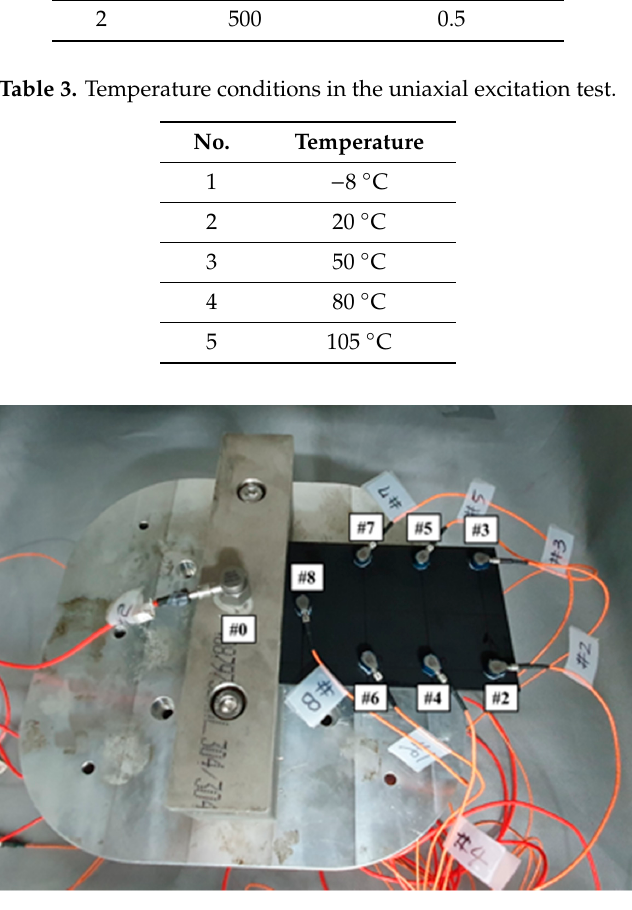
Figure 2. Location of the acceleration sensors: Seven locations (#2–#8) were selected to measure the dynamics of the CFRP specimen, and one location (#0) was selected for the exciter controller.